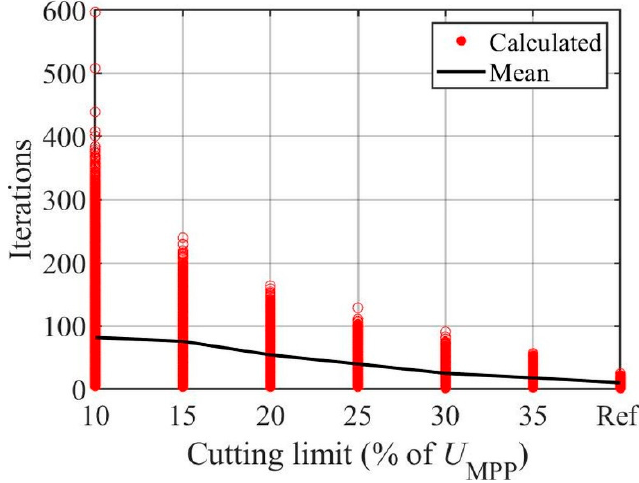
Figure 15. Number of iterations needed for fitting during the 40 min measurement period as a function of the cutting limit based on MPP voltage.